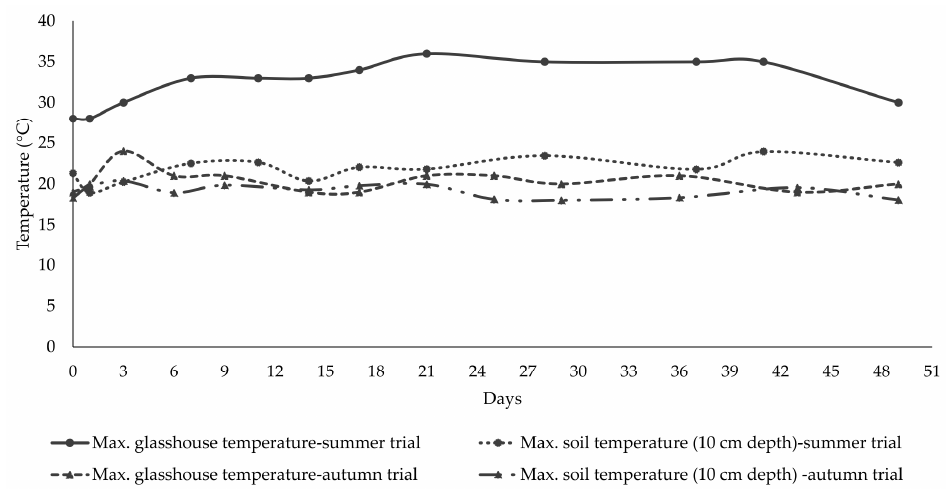
Figure 1. The maximum glasshouse and soil temperatures (at 10 cm depth) over the 49-day of both summer and autumn trials. In summer, cores were irrigated with 8 mm d − 1 of deionized water to maintain initial soil WFPS% of 40–50% and the average daily evaporation rate was ~6 mm d − 1 . In autumn, cores were irrigated with 5 mm d − 1 of deionized water to maintain initial soil WFPS % of 70–80% and the average daily evaporation rate was ~2 mm d − 1 . The cores were irrigated after gas measurements were taken. In summer, specific actions were taken to cool down the cores and the minimum glasshouse temperature during both summer and autumn trials was always maintained at ~17 °C.